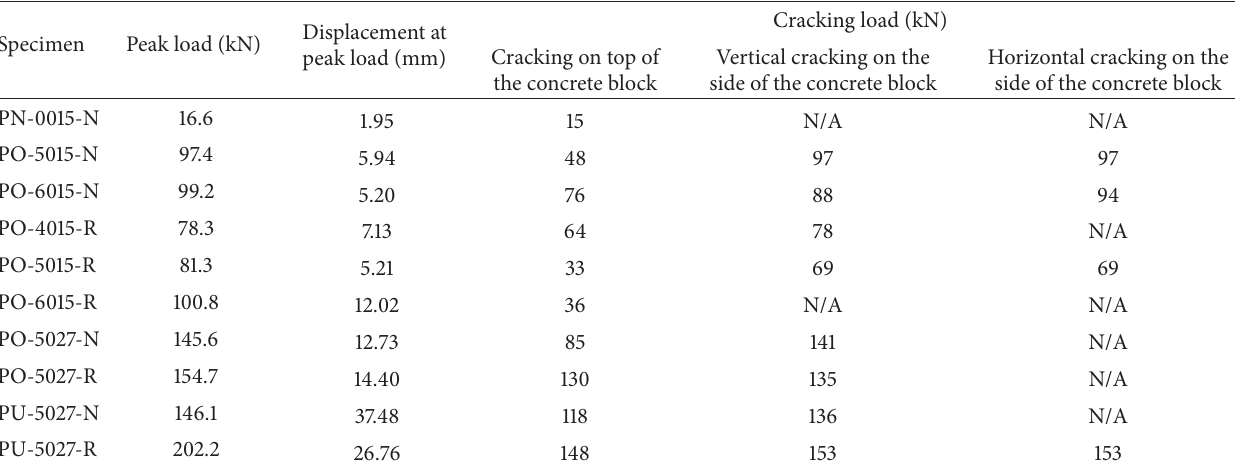
Table 3: Results of the pull-out test.